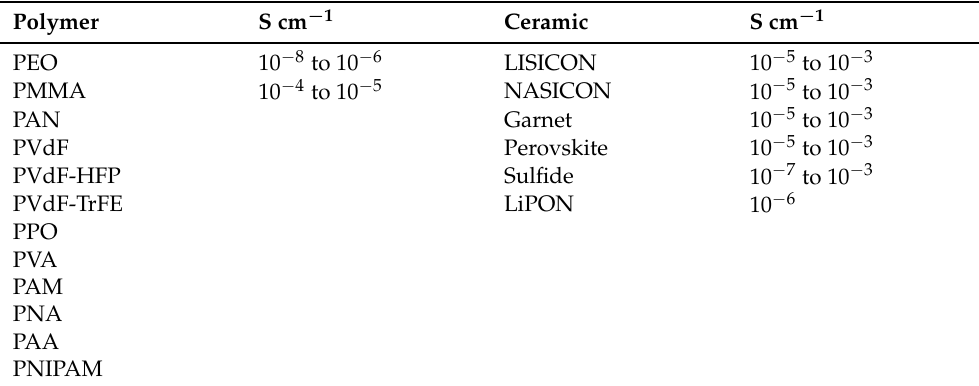
Table 18. Ionic conductivity of common solid-state electrolytes.